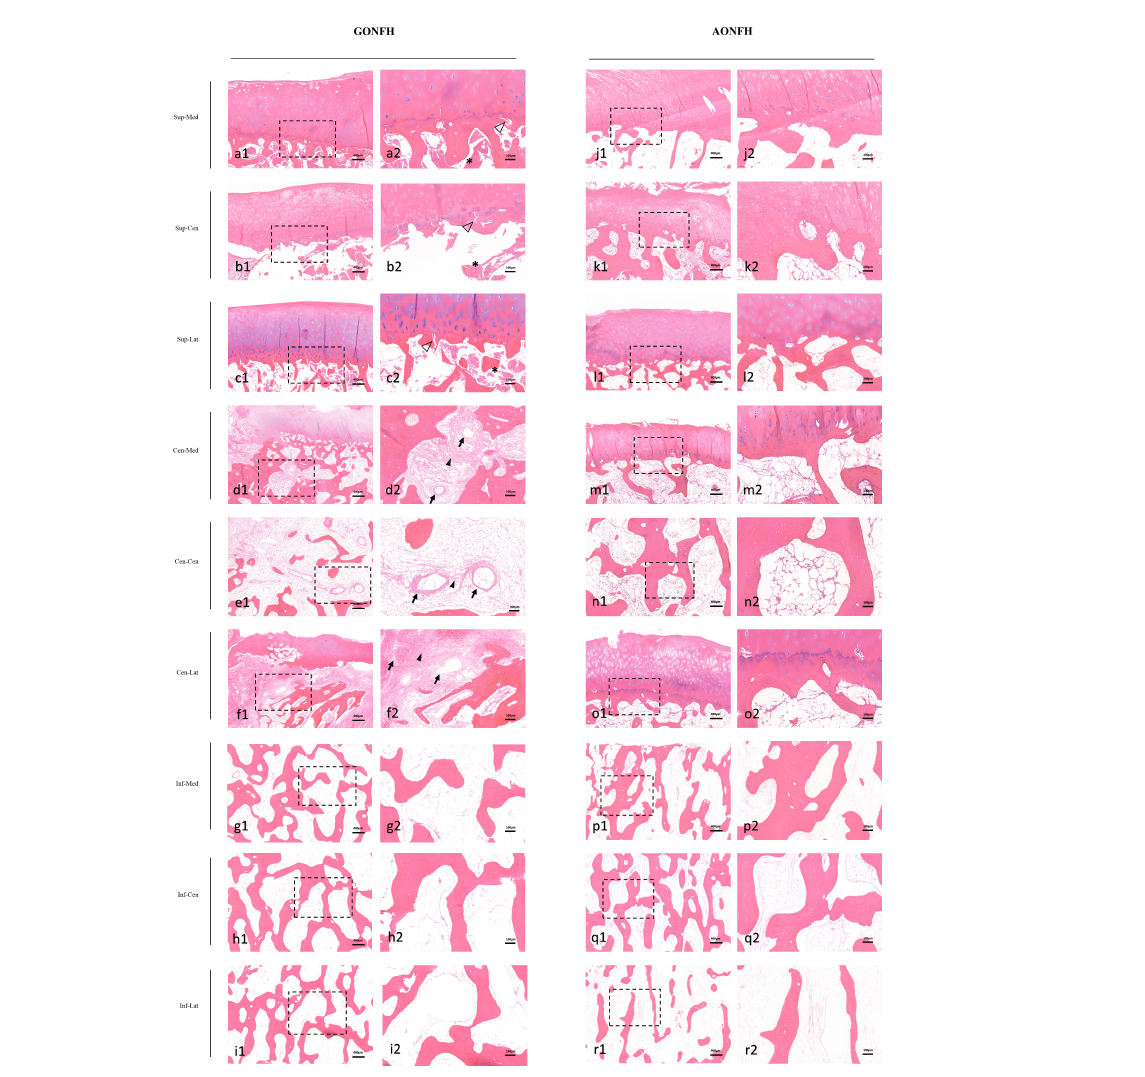
FIGURE 5 Photomicrographs of decalci fi ed sections of different ROIs in the femoral head from patients with GONFH (A-I) and patients with AONFH (J-R) . The decalci fi ed sections exhibit similar characteristics to those seen in imaging and typical ONFH appearances, with the patchy debris (*), microfracture (hollow arrows), vascular-rich granulation tissue (solid arrows) and reparative fi brovascular tissue (arrowheads). Stain: hematoxylin and eosin (HE); (a1-r1) magni fi cation: ×40; (a2-r2) magni fi cation: